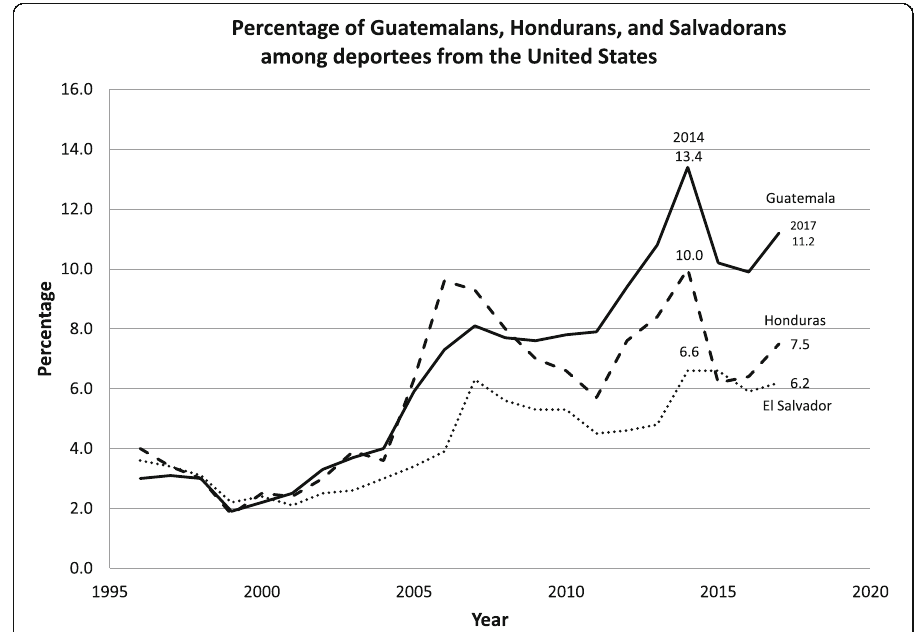
Fig. 18 Percentage of Guatemalans, Hondurans, and Salvadorans among deportees from the United States